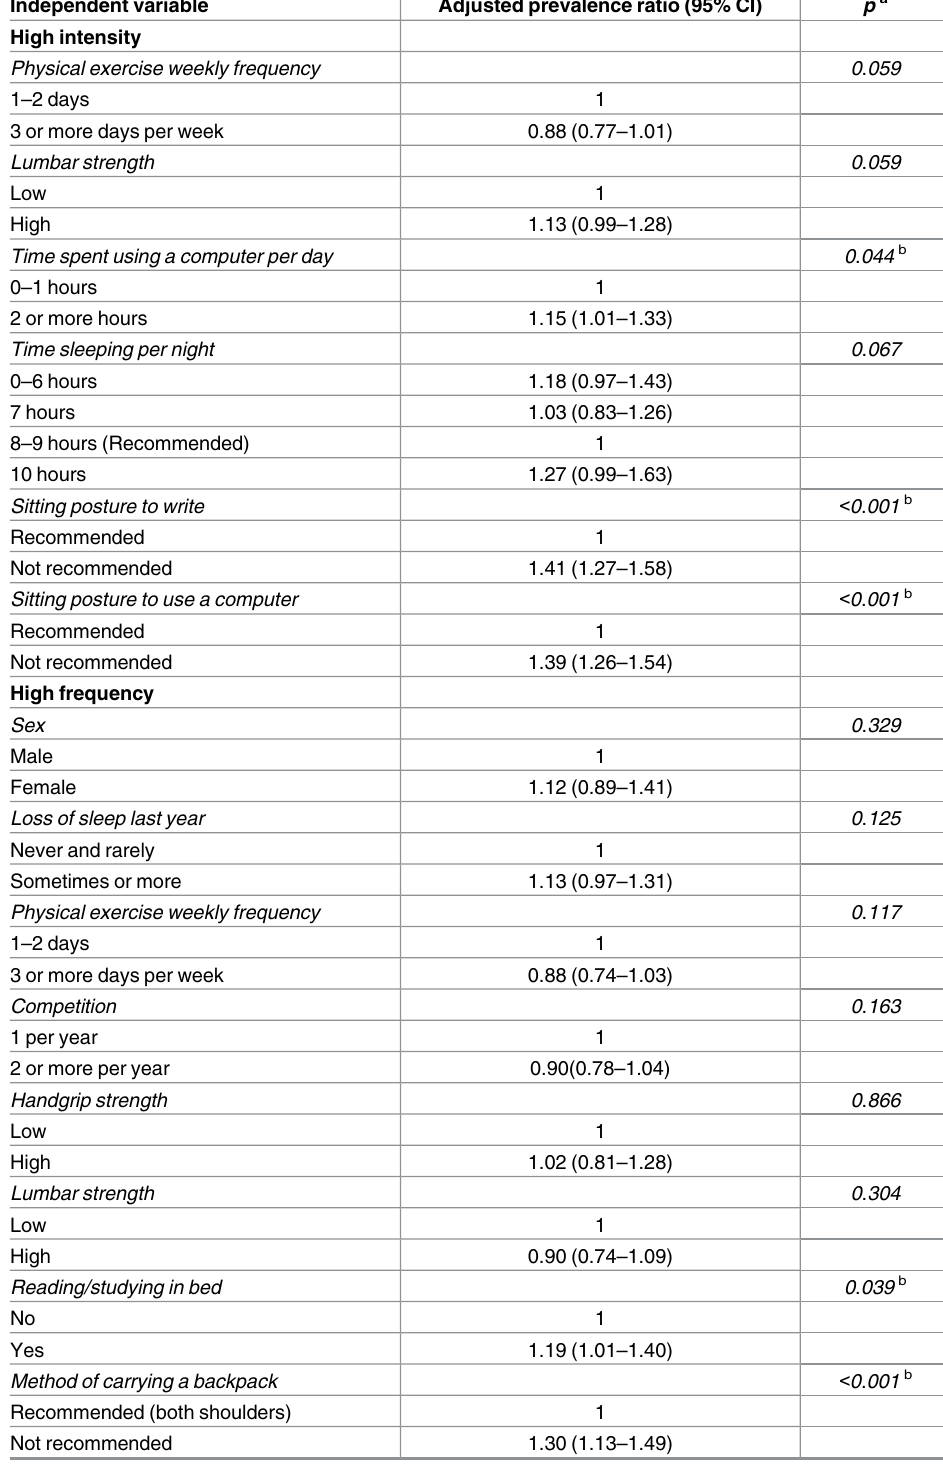
Table 6. Results of multivariate analysis and adjusted prevalence ratio for a high intensity and high frequency of back pain and independent